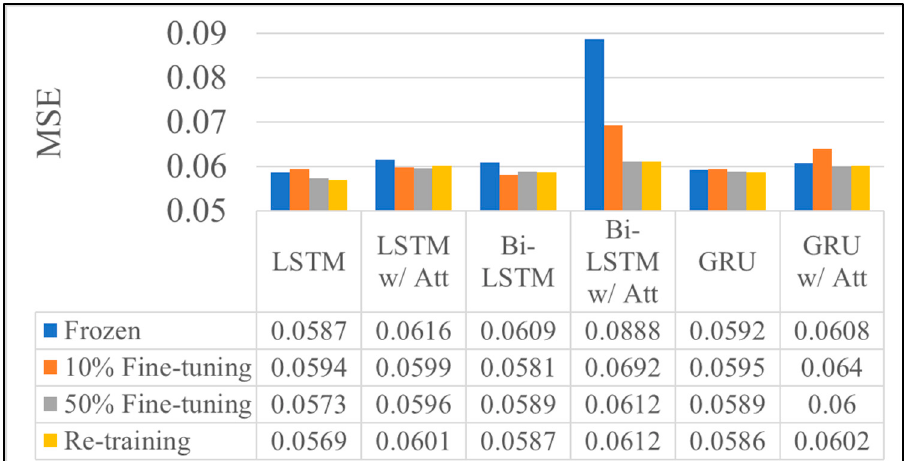
Figure 13. MSE of the target disease course prediction of TL-CDC with attention mechanism under k = 3.